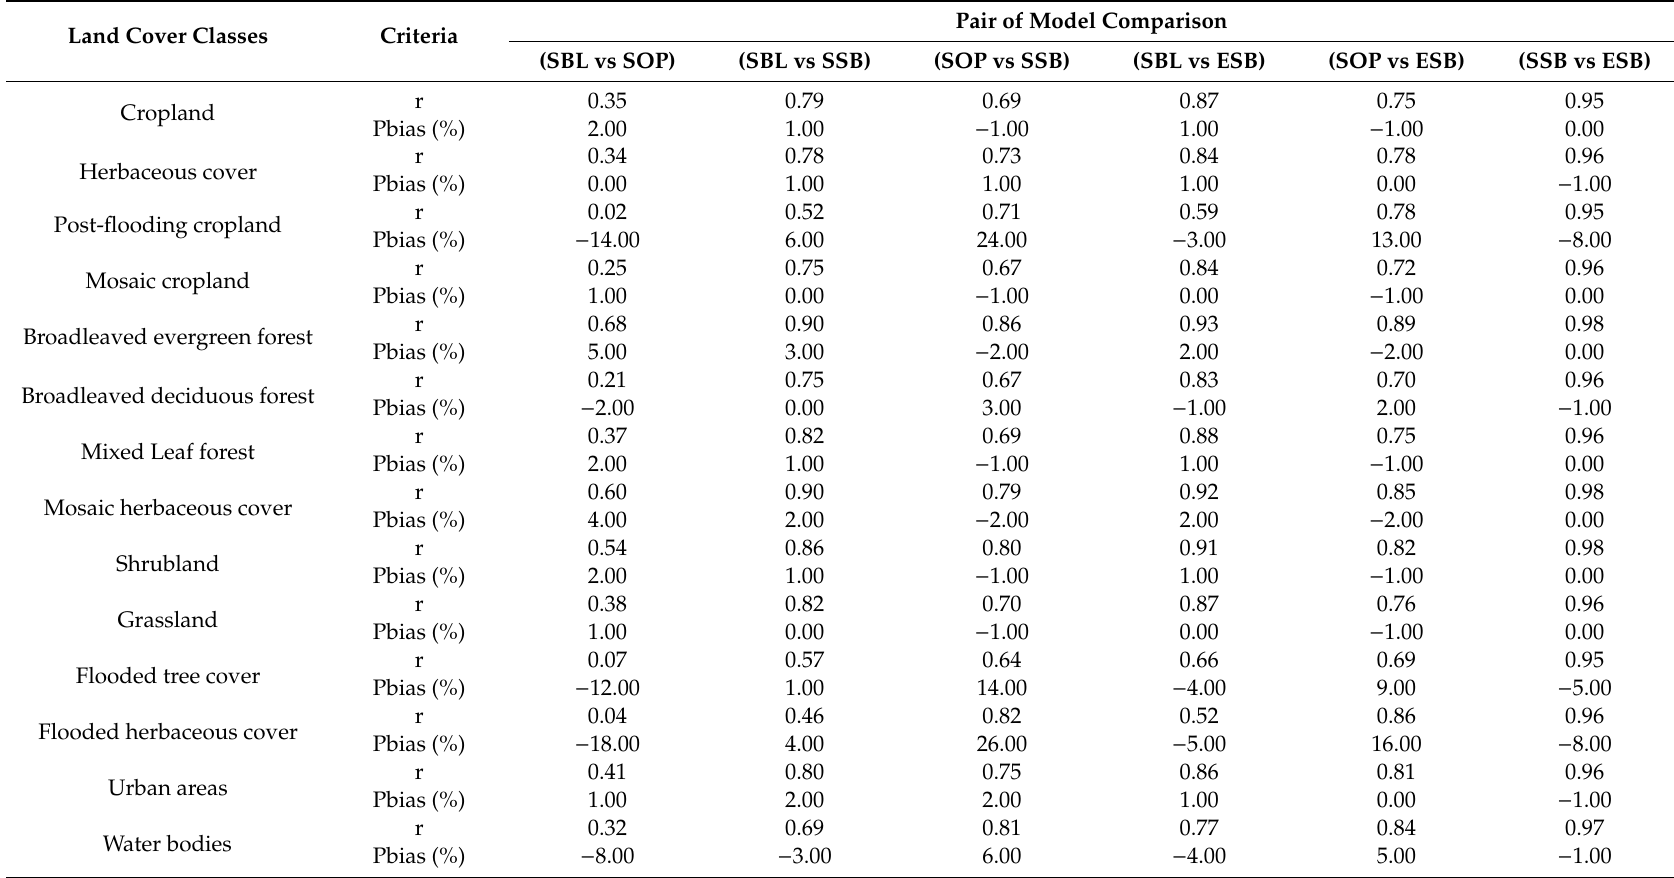
Table 9. The model performance metrics (derived from the daily evapotranspiration estimates computed using Surface Energy Balance (SEB) model for a total of 25 MODIS satellite overpasses) for each pair of SEB models comparison over di ff erent land cover classes in the Kilombero Valley (KV) river basin. SBL, Surface Energy Balance Algorithm for Land (SEBAL) model; SOP, Operational Simplified Surface Energy Balance (SSEBop) model; SSB, Simplified Surface Energy Balance Index (S-SEBI) model; ESB, ensemble mean of daily ET estimates from the three models (SEBAL, SSEBop, and S-SEBI); r, coe ffi cient of correlation; and Pbias, Percent